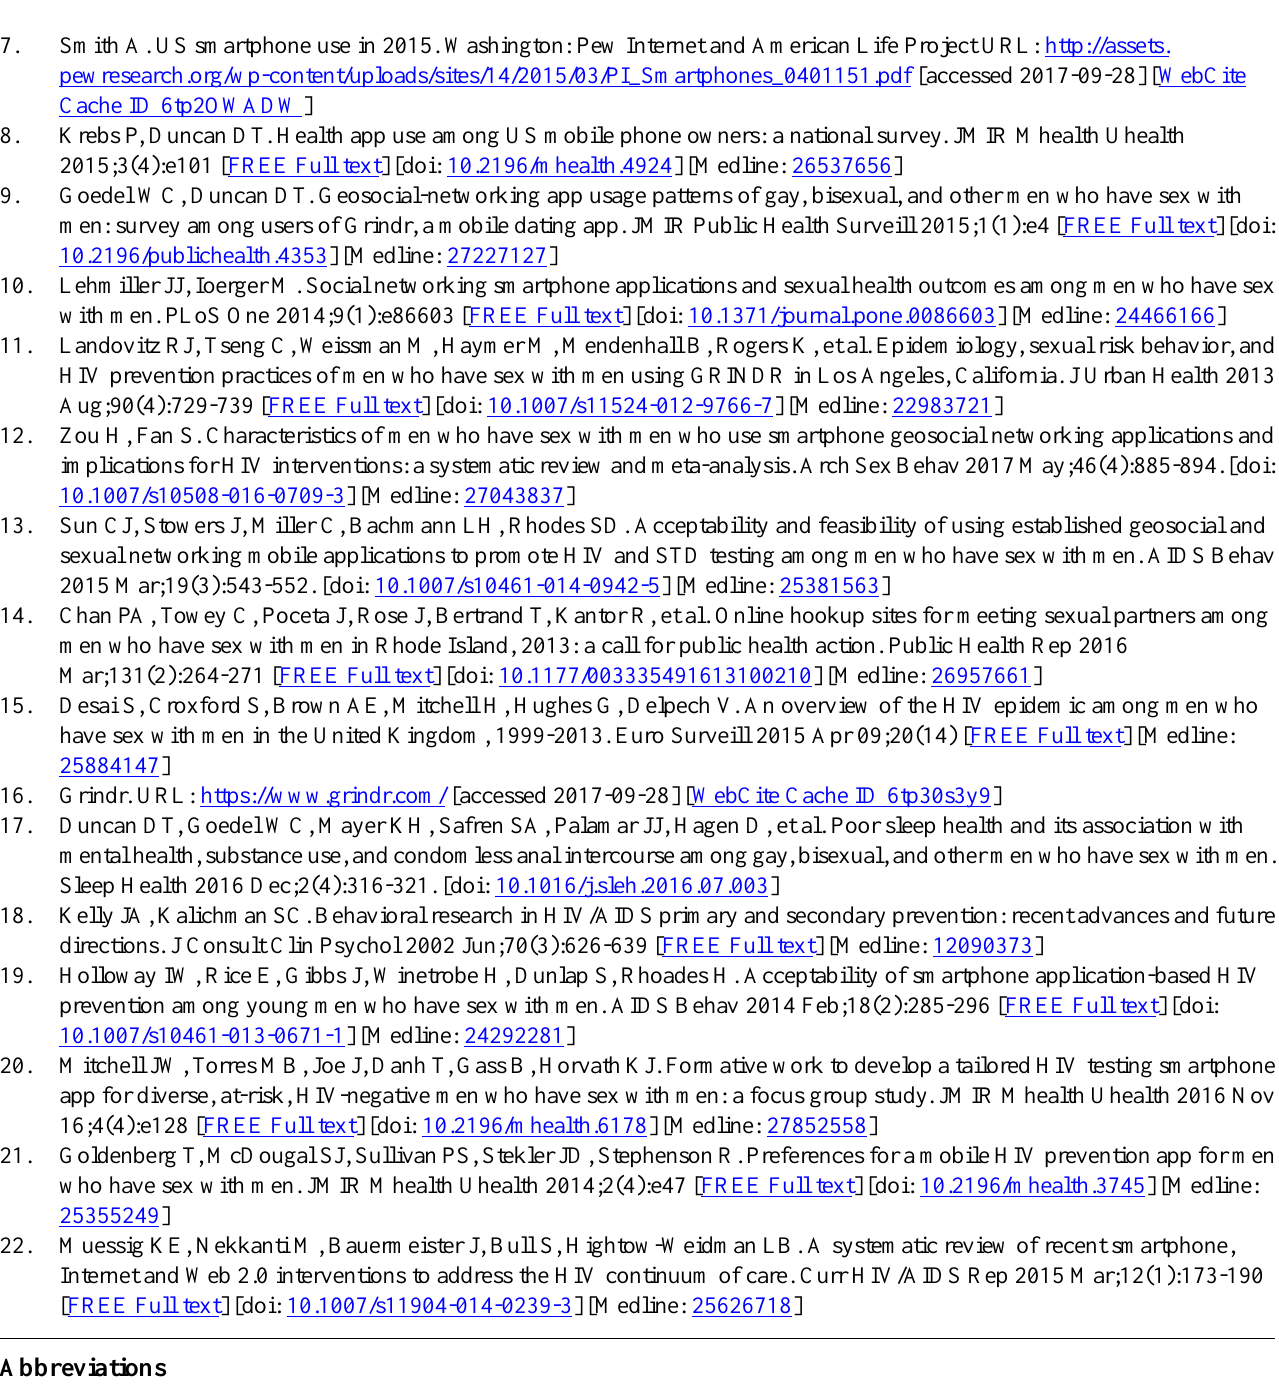
Abbreviations GBL: gamma-butyrolactone GHB: gamma-hydroxybutyric acid GPS: Global Positioning System HIV: human immunodeficiency virus LSD: lysergic acid